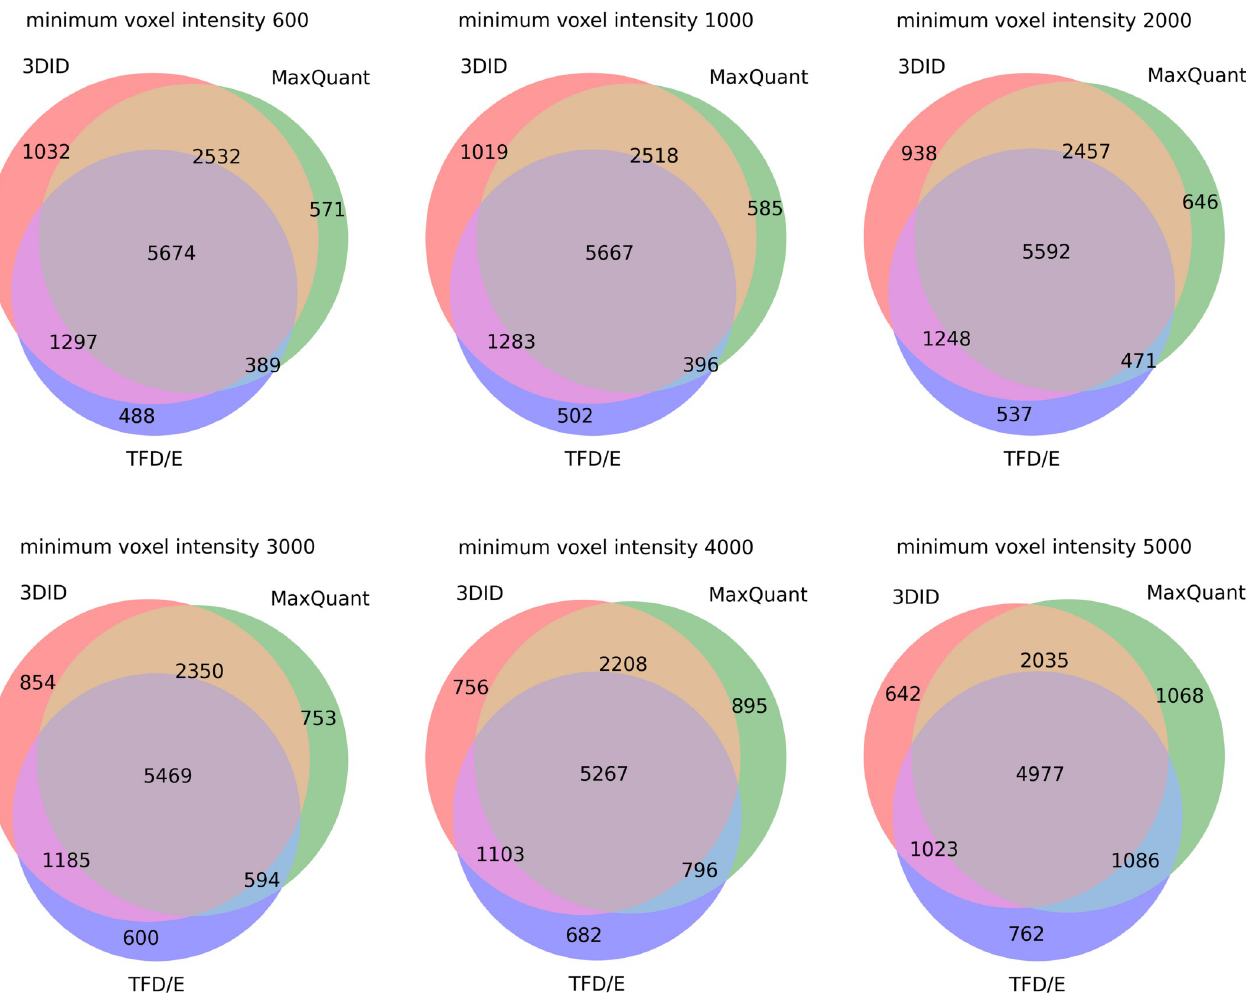
Fig 11. Peptide identifications of the features detected with 3DID and varying minimum voxel intensities 3DID, and the identified features from TFD/E, and MaxQuant.